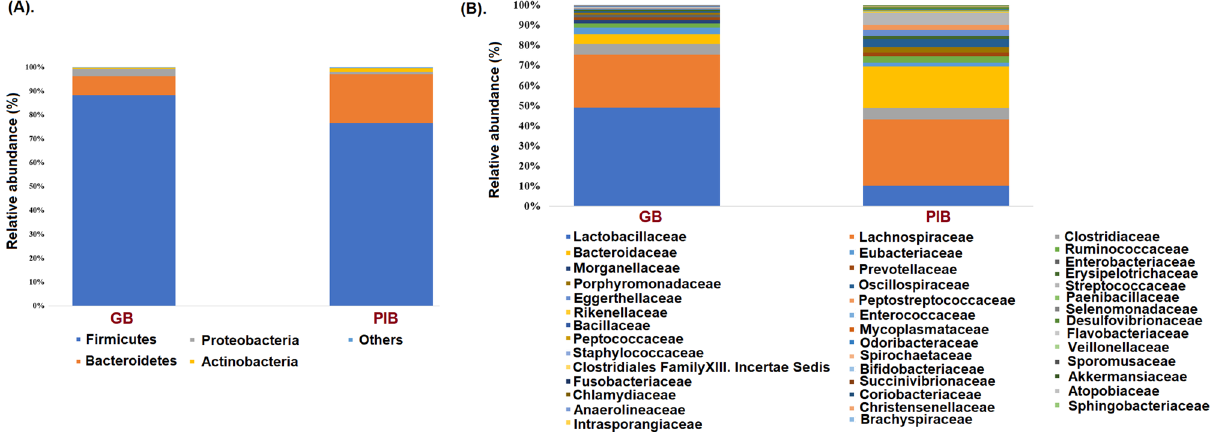
Figure 1. Stack bar plot represents relative abundance differences at ( A ) phylum and ( B ) family levels between GB and PIB